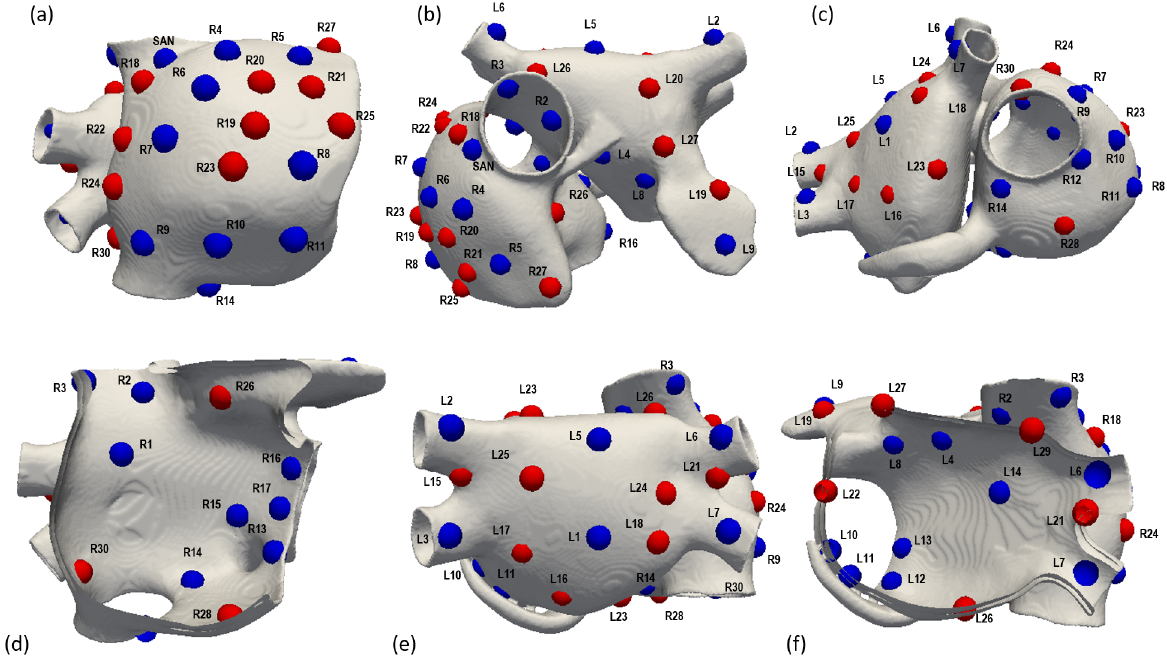
Fig 1. Atrial model and localization of the ectopic foci. Localization of the 58 ectopic focus sites (includingthe SAN) shown from six different views of the atria. Blue points labelledas R1 to R17 and L1 to L14 are the ectopic sites belongingto the validationset. Red points labelledas R18 to R30 and L15 to L27 represent the additionalectopic sites to cover the atrial walls.